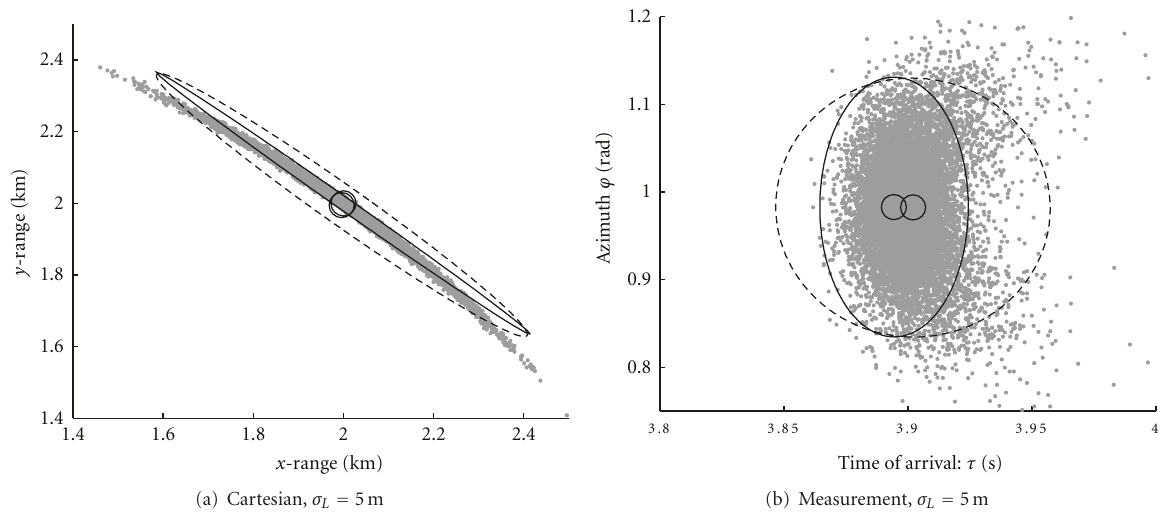
Figure 19: Nonlinear transformations: (a) shows approximations of the transformation of measurements into Cartesian coordinates; (b) show results for the transformation of Cartesian estimates into measurement coordinates. Solid line ellipses correspond to linearization, dashed lines to UT, grey dots represent samples from the true density: for strong bearing dependencies both approximation techniques